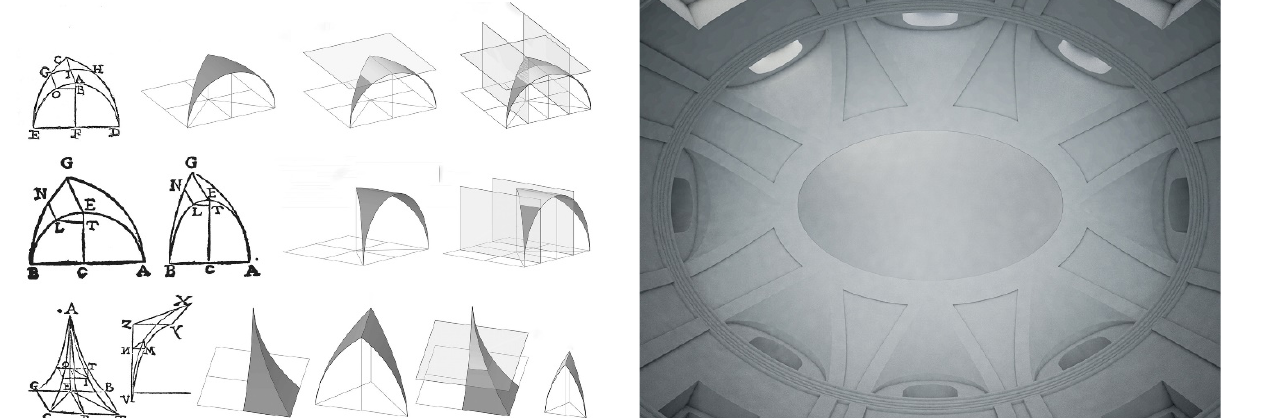
Figure 4. Lunettes in the Modo di misurare le fabriche (Modelling: R. Spallone)